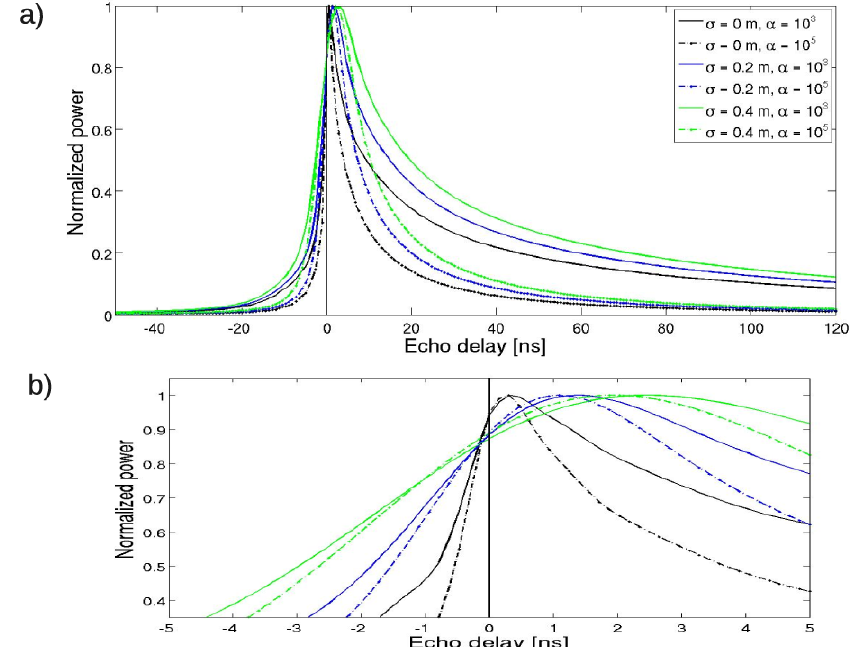
Figure 4. Simulated CryoSat-2 echoes over sea ice floes for (a) the typical range of delay times provided in the level 1B product over sea ice, and (b) a zoomed-in plot showing the behavior near the echo delay time of 0. Solid lines correspond to α = 10 3 and dashed lines correspond to α = 10 5 .